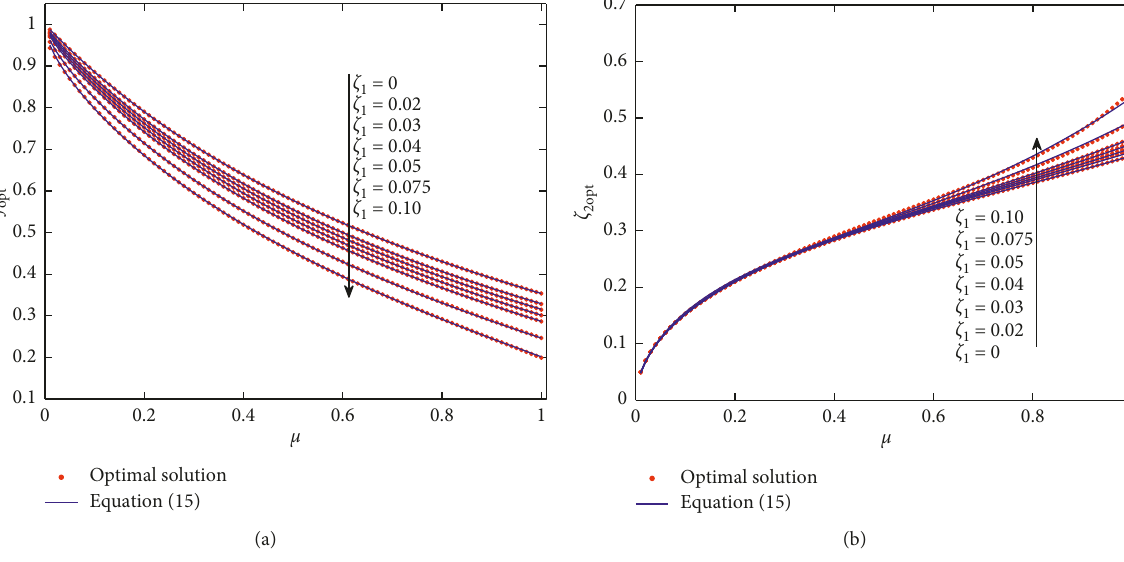
Figure 7: The relationship between the revised fitting formula value and the actual optimal value with the TMD mass ratio and the damping ratio of the main structure under stationary white noise excitations. (a) Optimal frequency ratio. (b) Optimal damping ratio.